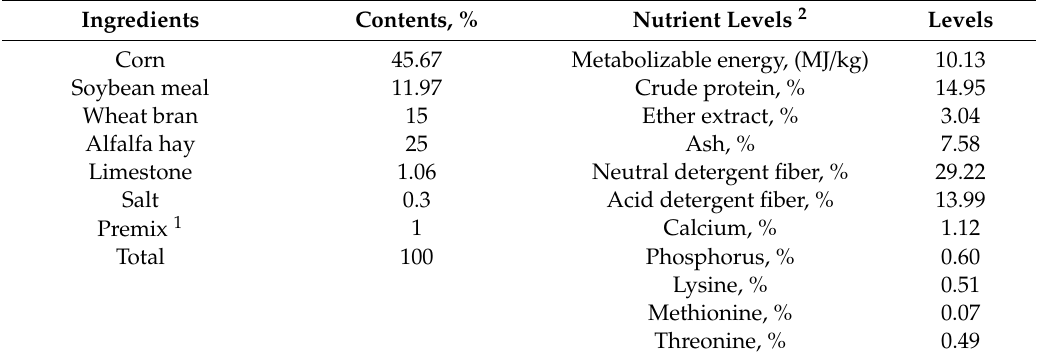
Table 1. Composition and nutrient levels of basal total mixed ration (TMR) (dry matter basis).